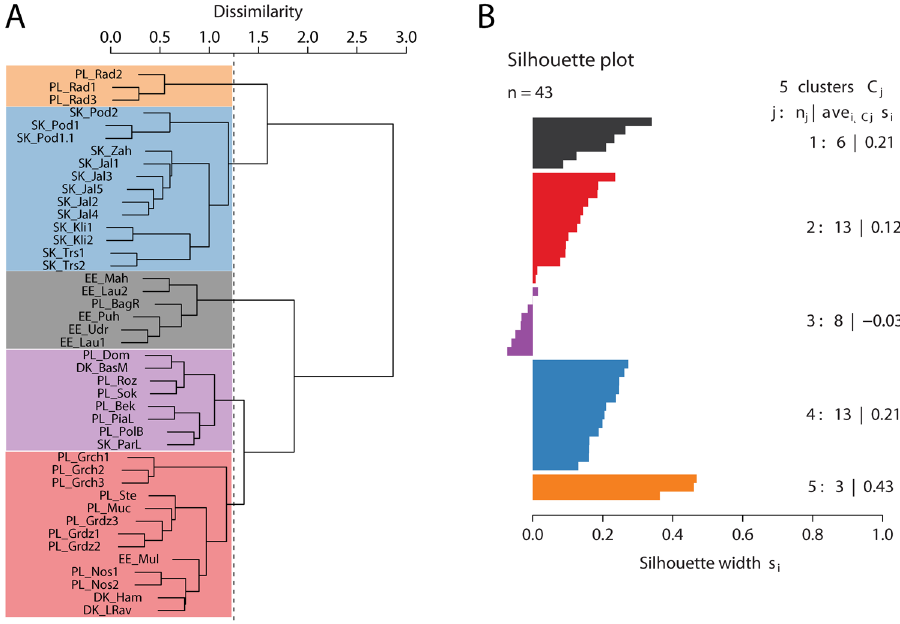
Figure 2. Analysis of vegetation similarity between relevés. ( A ) Cluster analysis by Ward agglomeration; ( B ) The corresponding Silhouette plot allows cluster patterning and significance to be evaluated. Locality